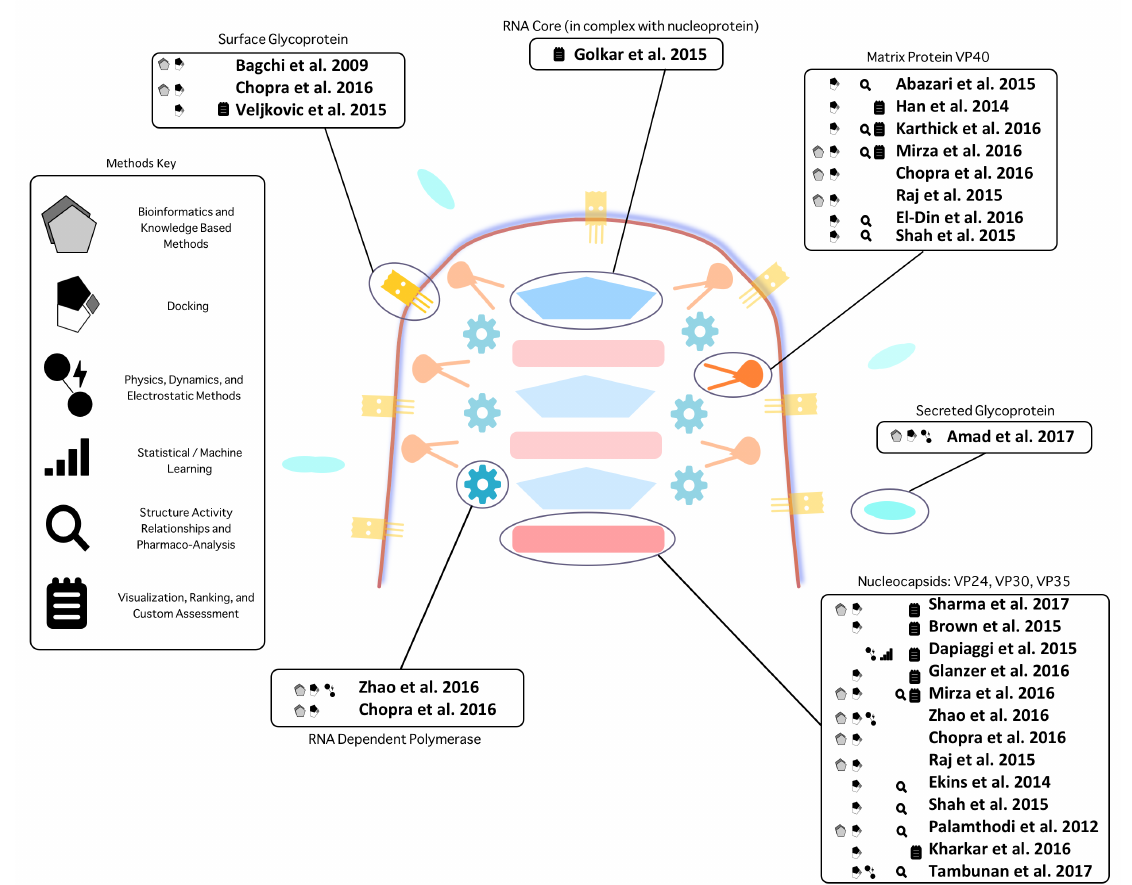
Figure 2. Illustration of Ebola targets investigated in the studies reviewed. The target scope of each study and broad classification of the investigatory approaches is shown. We broadly categorize distinct methods of studies into five classes: (1) Bioinformatics and knowledge based methods including sequence alignment and analysis, residue importance prediction, evolutionary inference, template-based modeling, and binding site prediction; (2) Physics, dynamics, and electrostatic methods including energy minimization, geometry optimization, molecular docking, molecular dynamics, and computational alanine scanning. (Molecular docking is the most popular methodology and is therefore distinguished separately); (3) Structure activity relationship and pharmacoanalysis methods including compound similarity methods, RMSD analysis, structural fingerprinting, pharmacophore analysis, pharmacokinetics, and pharmacodynamics; (4) Statistical and machine learning methods including principal component analysis, interactome similarity analysis, SVM models, Bayesian network models, and neural network models; (5) Visualization, Ranking, and Custom Assessment methods including interactome signature ranking, assay integration, and visual inspection and analysis. Target coverage is weighted towards VP24, VP30, VP35, and VP40; likely due to a greater degree of structural knowledge for these targets and that the authors tend to believe that these proteins are most important for virulence. Others often use structure prediction methods and other techniques to investigate unsolved targets. A diverse array of computational methods have been applied to find treatments against Ebola virus, and it is likely that some of them may yield effective treatments, with multitarget approaches, represented in multiple target boxes, indicating the most